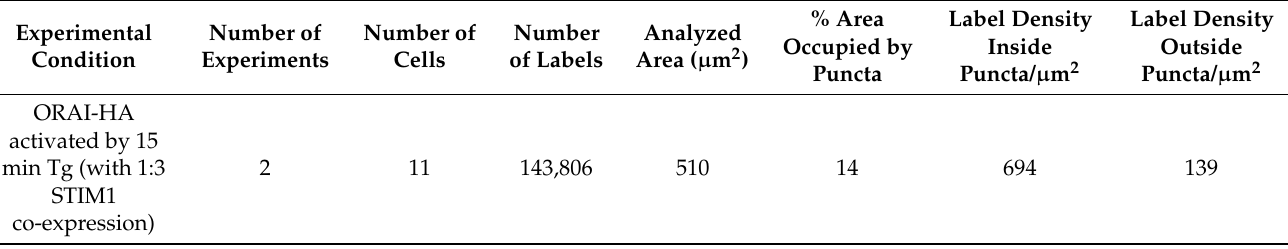
Table 2. Measurements of ORAI1 distributions inside and outside puncta after maximally store-operated calcium entry (SOCE) activated cells.